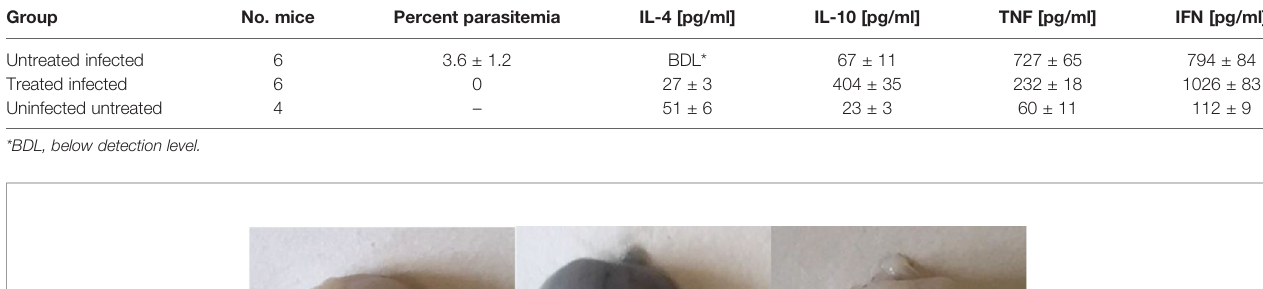
TABLE 5 | Cytokine levels in mice treated with artemisone.